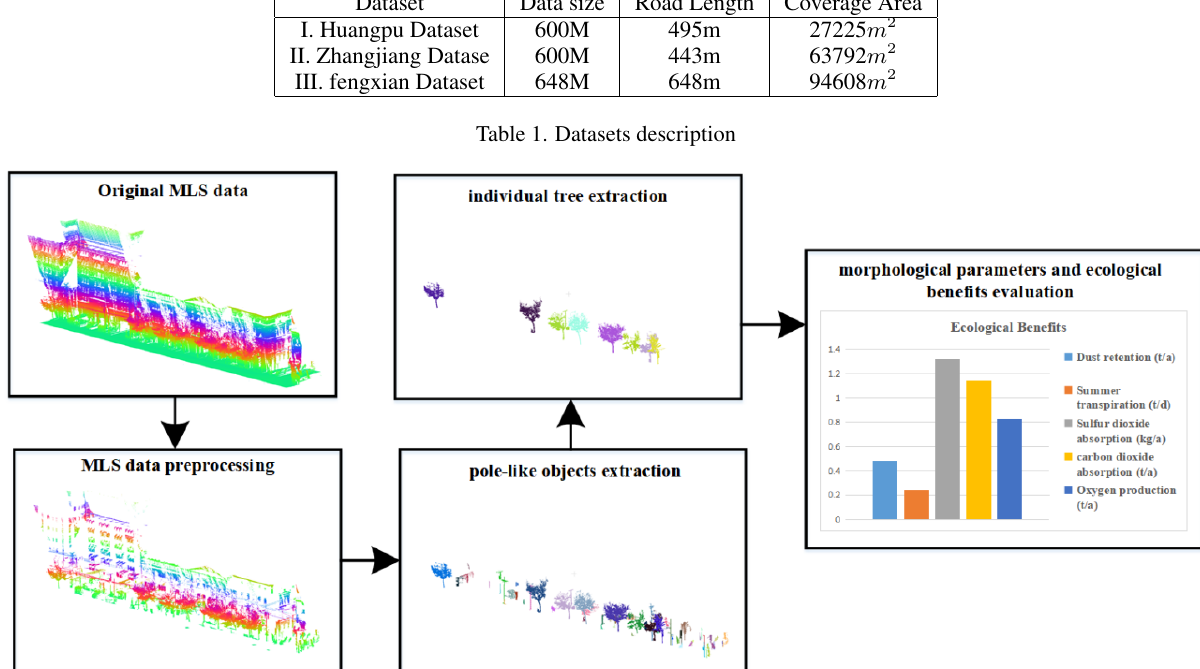
Figure 1. The workflow of the proposed method.